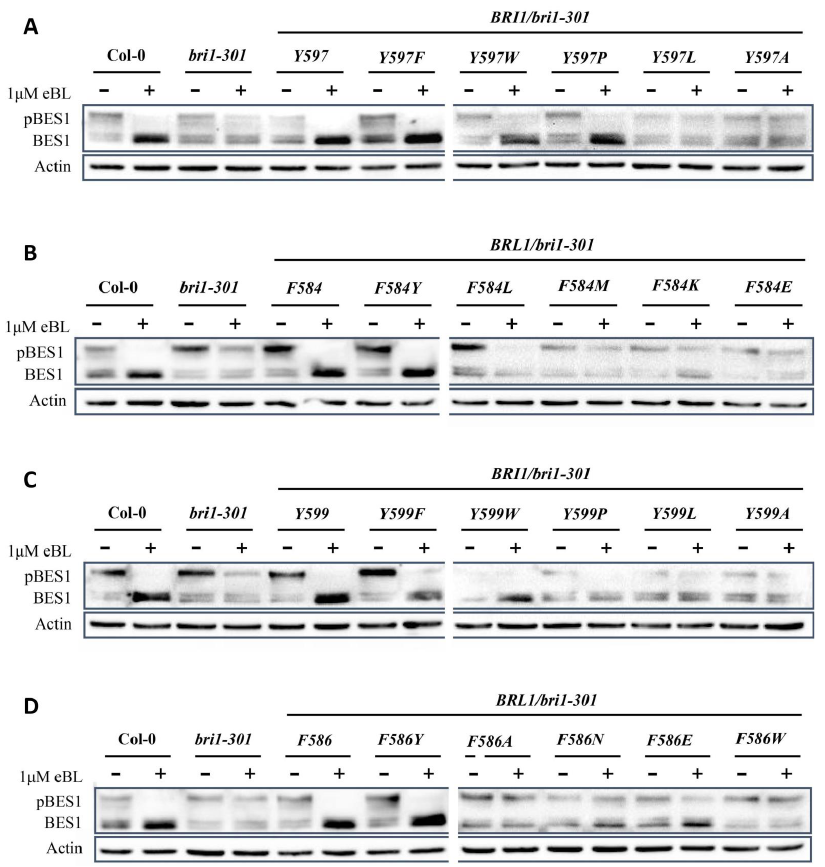
Figure 6. BR receptors with Tyrosine597 or Tyrosine599 showing the highest efficacy to dephosphor- ylate BES1. ( A – D ) Immunoblotting of eBL-induced dephosphorylation of BES1 in Col-0, bri1-301 , and transgenic plants in a bri1-301 background. ( A ) Dephosphorylation vs. phosphorylation level of BES1 in transgenic plants expressing AtBRI1 mutated at position 597. ( B ) Dephosphorylation vs. phosphorylation level of BES1 in transgenic plants expressing AtBRL1 mutated at position 584 (cor- responding to residue 597 of AtBRI1). ( C ) Dephosphorylation status of BES1 in transgenic plants expressing AtBRI1 mutated at position 599. ( D ) Dephosphorylation analysis of BES1 in transgenic plants expressing AtBRL1 mutated at position 586 (corresponding to residue 599 of AtBRI1). An anti-BES1 antibody was used to detect the phosphorylation status of BES1, and Actin served as a loading control. All experiments were repeated independently three times with similar results.